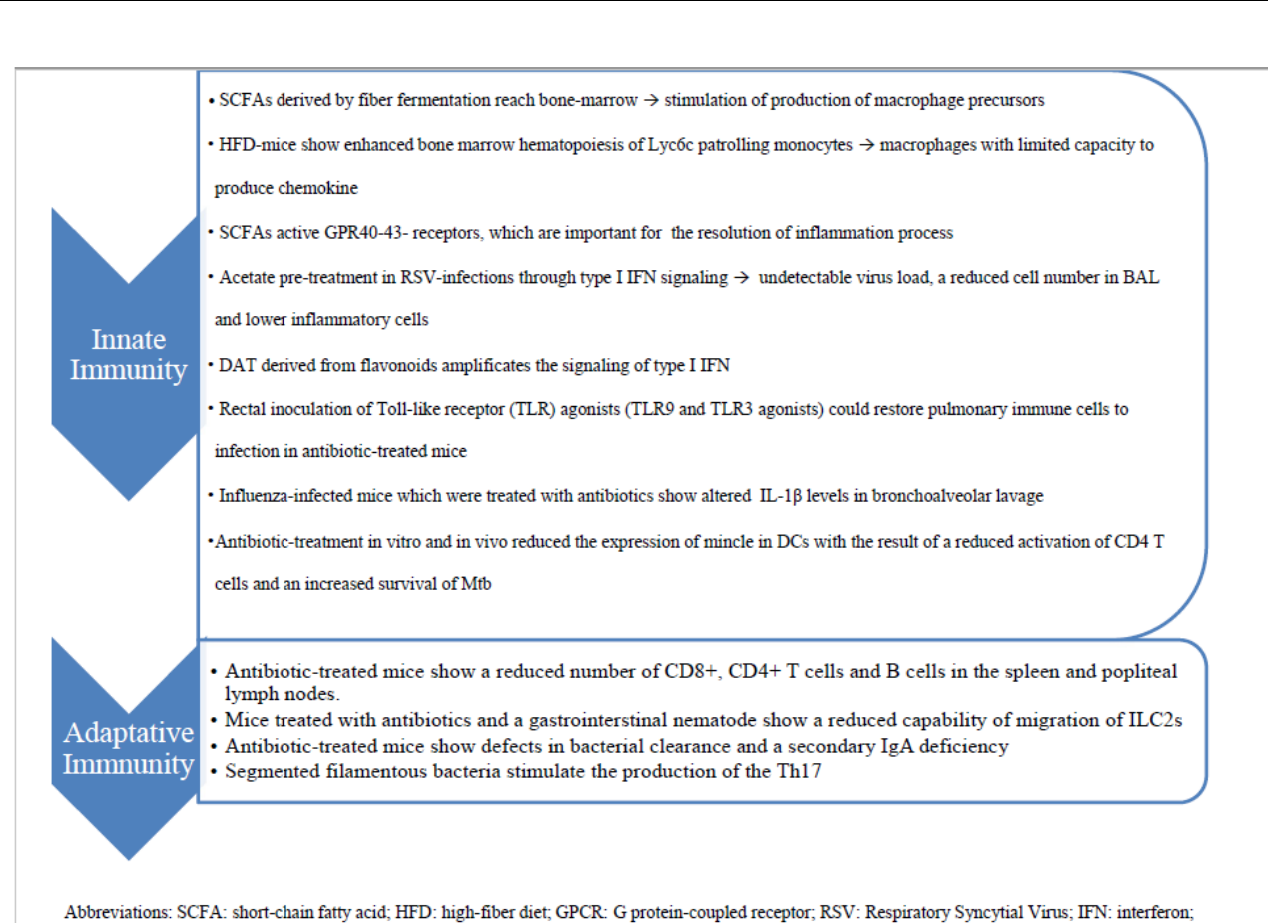
Figure 1. The diagram summarizes the immune mechanisms by which gut – lung axis works and potentially influences the answer to infections.